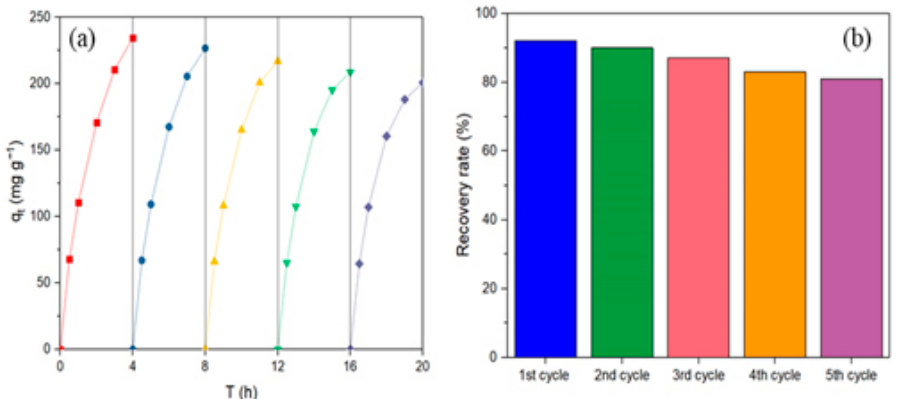
Figure 6. Adsorption capacity ( a ) and AQ2S recovery rate ( b ) variation over the adsorption/regeneration cycle.